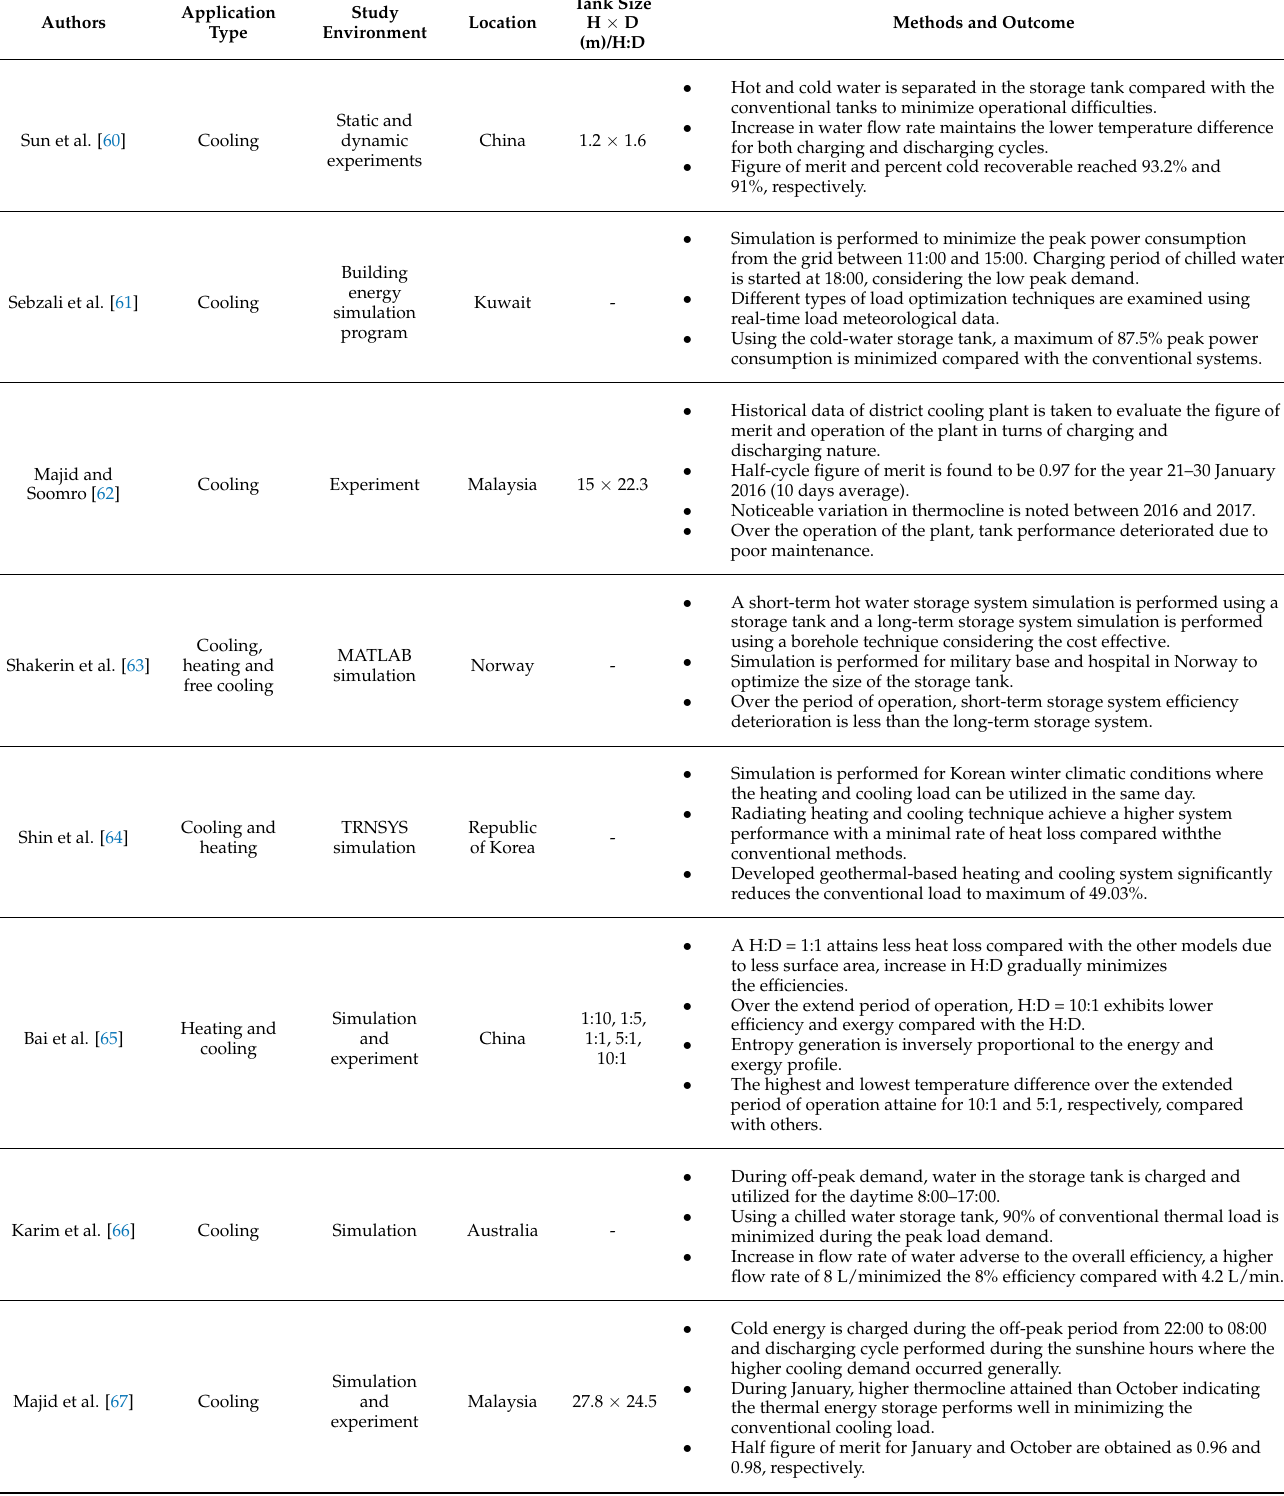
Table 1. Literature study of heating and cooling thermal energy storage